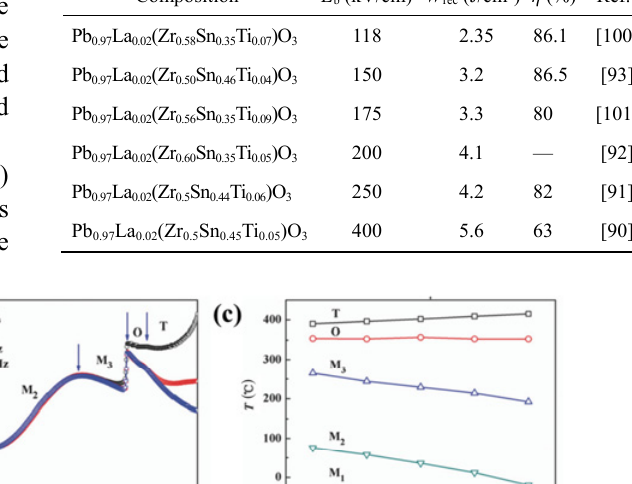
Energy storage performance of PLZST ceramics with different ratios of Zr, Sn, and Ti